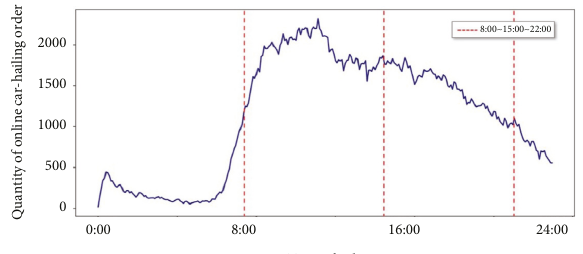
Figure 7: The average number of online car-hailing orders at time intervals in a day.